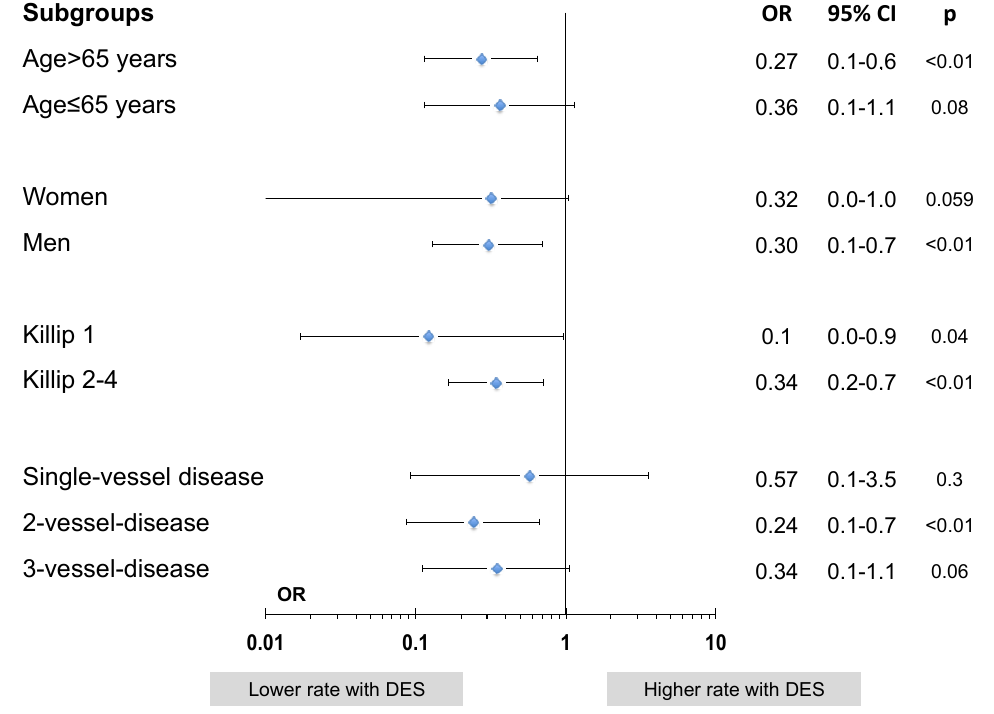
Figure 2. Event rates in diabetic STEMI patients treated with DES vs. BMS: Comparison of ( A ) ischemic events, ( B ) bleeding events and ( C ) all-cause mortality. Multivariate model with stent type adjusted for age, gender, cardiogenic shock, anterior STEMI, type and duration of P2Y12-inhibitor and number of stents implanted. Cumulative events = ST + AMI + TLR.